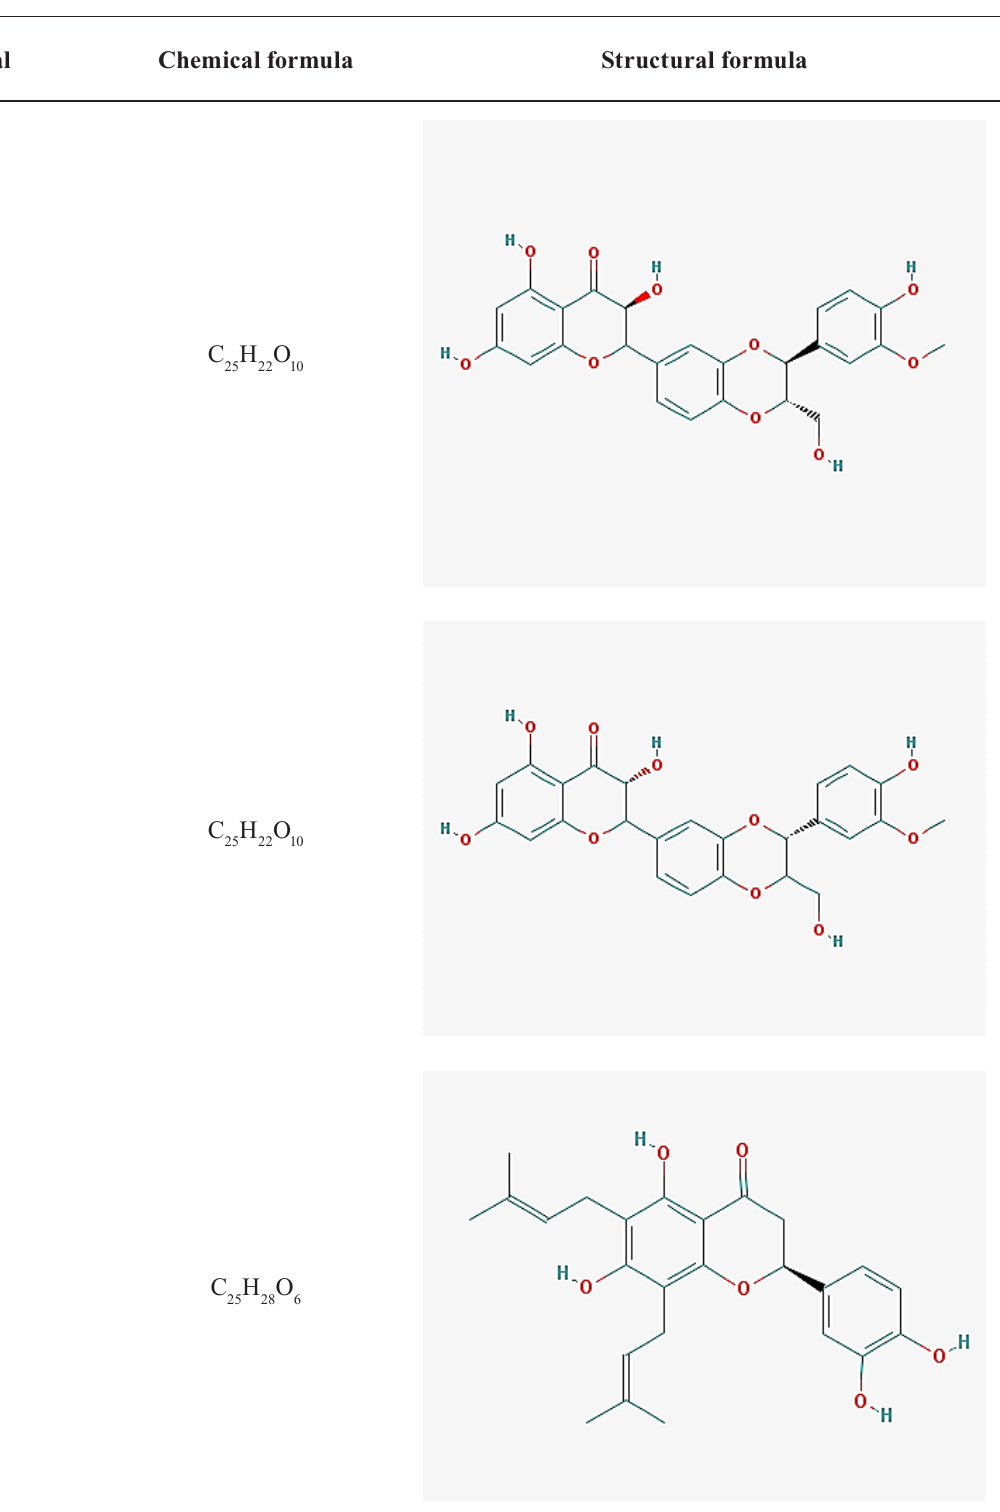
TABLE I - P hytochemicals from Tanacetum parthenium and Silybum marianum